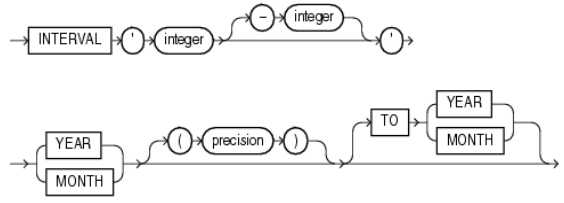
Figure 16. Interval Year to Month—syntax [39].